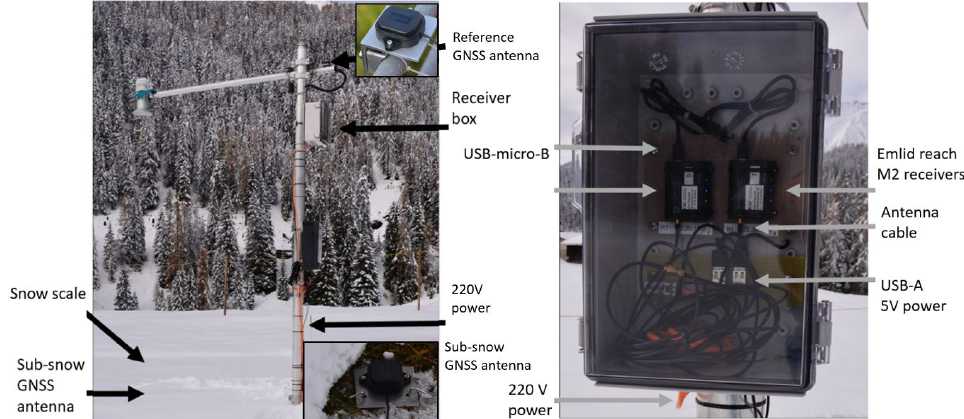
Figure 2. Davos Laret site equipped with the fixed, low-cost GNSS refractometry snow monitoring system and a snow scale. Low-cost multi-frequency and multi-system U-blox ANN-MB-00 antennas and Emlid Reach M2 receivers were deployed for near real-time